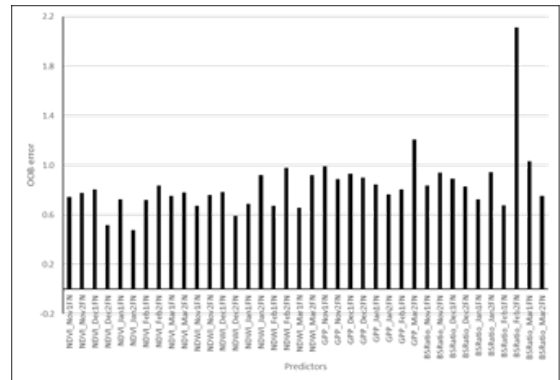
Fig. 6 Predictor importance based on OOB